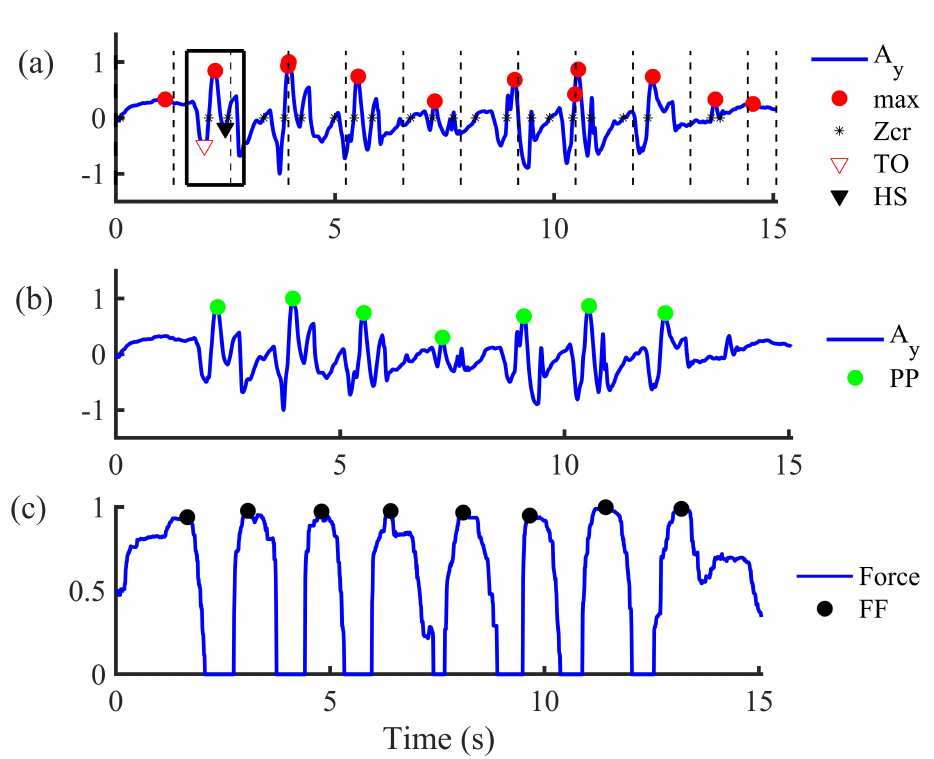
Figure 6. Insole-based gait segmentation in different strides: ( a ) Initial acceleration data from the insole without applying the suggested algorithm (Ay: acceleration in y-axis; Zcr: zero-crossing; TO: toe-off; HS: heel strike); ( b ) Acceleration data after applying the suggested algorithm (PP: peak-to- peak for strides detection). The Stride is therefore the difference between one green peak and the second next green peak; ( c ) The total force from the three FSRs (FF: foot flat). The square in solid line represents the moving window in which its length is equal to the locking period; the red circle is the original peak detected and the green circle indicates the correct peak detected after applying our proposed